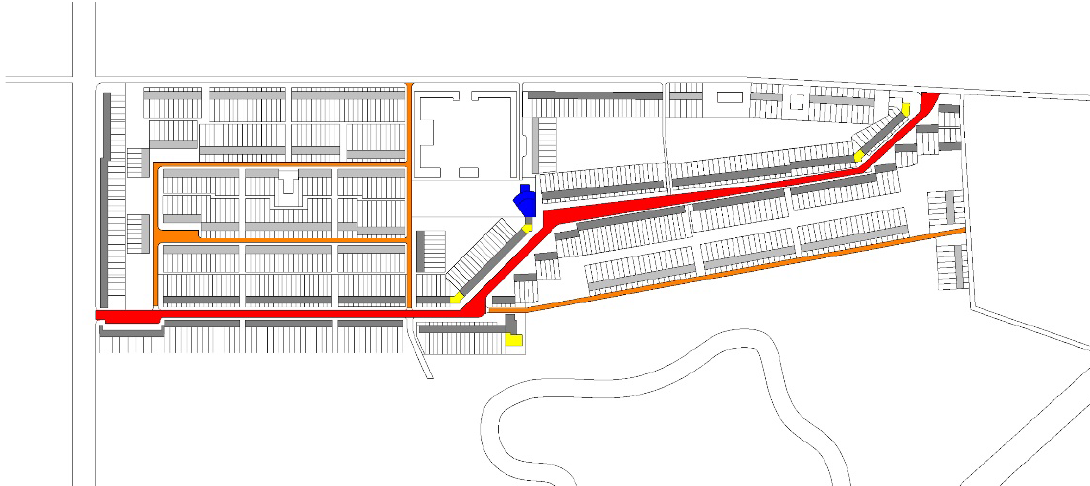
Figure 24. Formal structure, Siedlung Praunheim. Drawing by Manlio